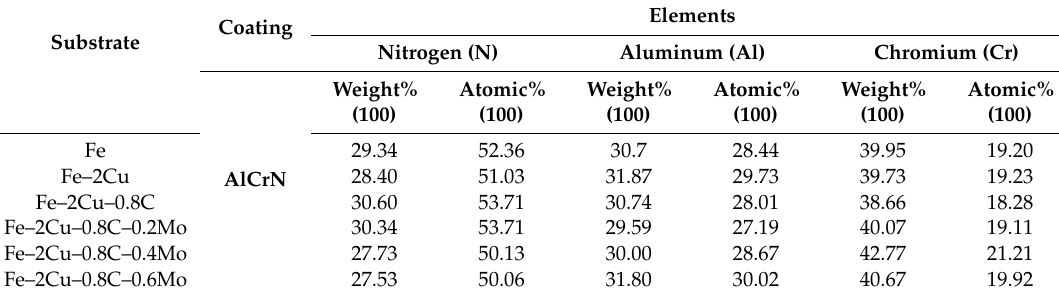
Table 7. Elemental composition analysis on the coated samples.